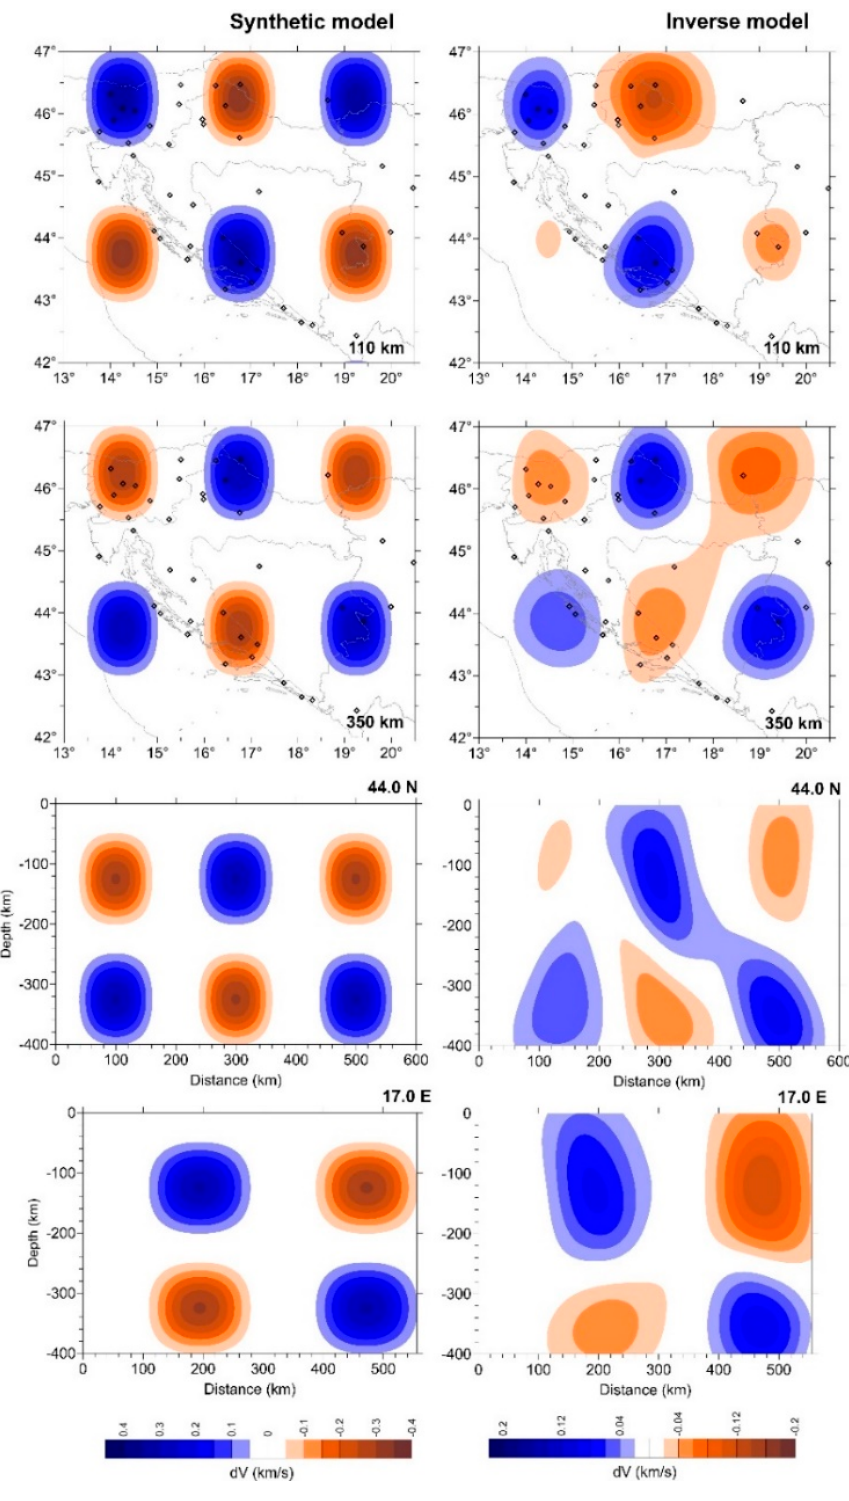
Figure A1. Resolution test—spike test. Positive and negative velocity anomalies (dV = ±0.4 km/s) were superimposed in a regular pattern on the ak135 model and recovered by an inversion with the parameters used for the solution model. A synthetic model is shown together with the inversion slices at 110 km and 350 km (upper part), and at the west–east profile (44.0 N) and south–north profile (17.0 E; lower part). Better resolution is achieved at greater depths. Inversion model shows that applied geometry can resolve the structure of the Dinarides.